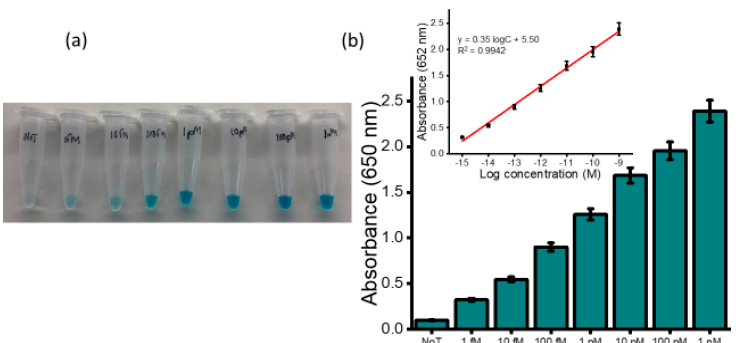
Figure 3. Sensitivity of the assay. ( a ) Picture of the naked-eye detection of HOTAIR derived from a series of synthetic lncRNA sequences (1 fM-1 nM) (left panel); ( b ) the corresponding bar diagram for absorbance at 652 nm (right panel). The inset shows the analogous calibration plot with error bars representing the standard deviation of three independent experiments.